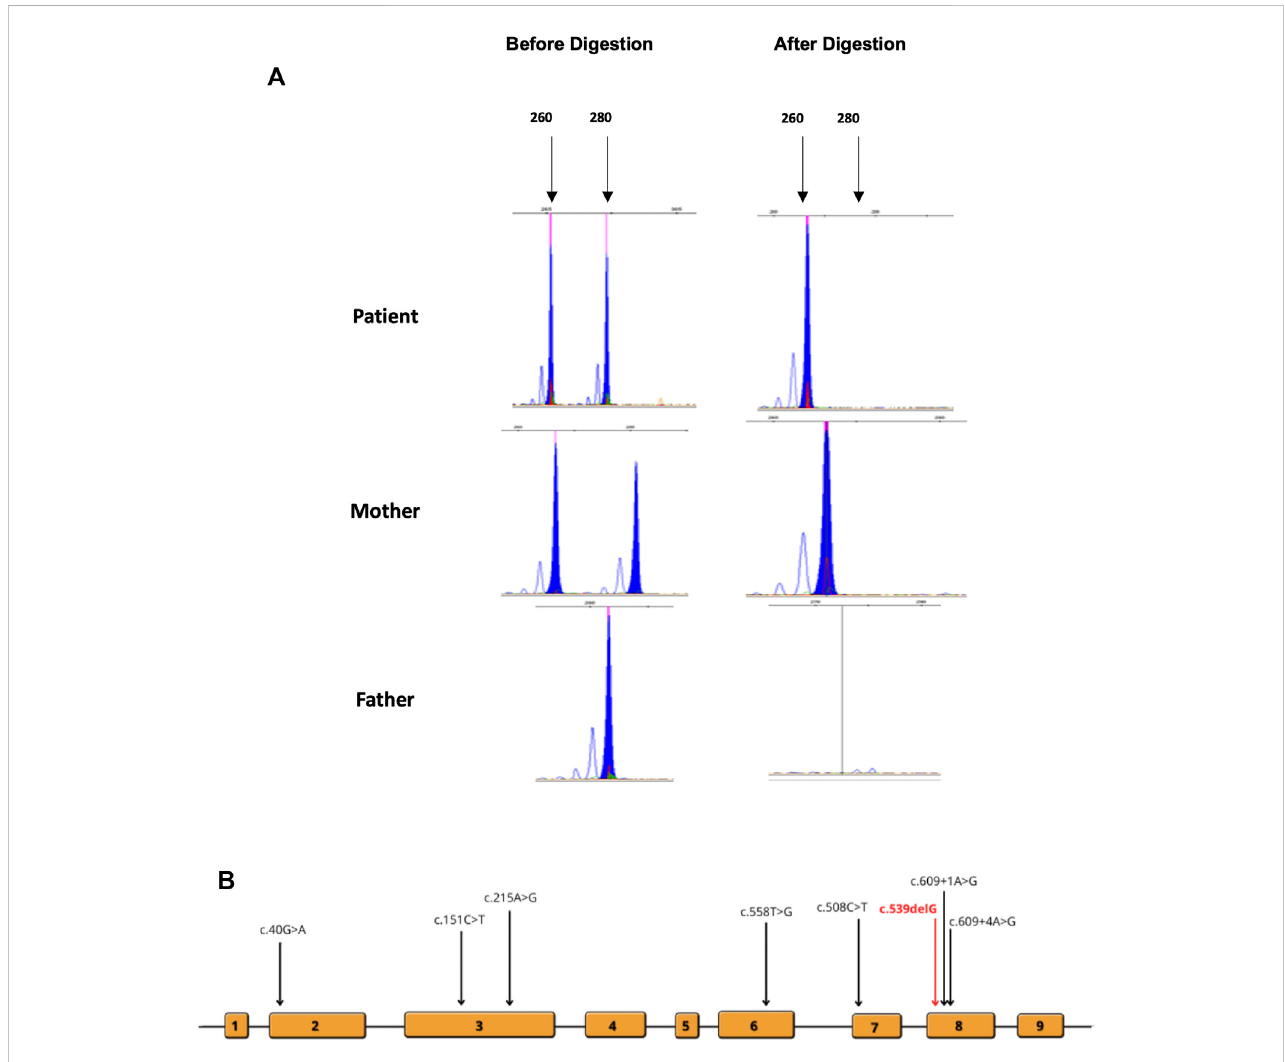
FIGURE 3 (A) Analysis of X-inactivation as signi fi ed by the AR locus. DNA was ampli fi ed before and after HhaI digestion. (B) Locations of the previously reported mutations are indicated on the schematic diagram of the gene and